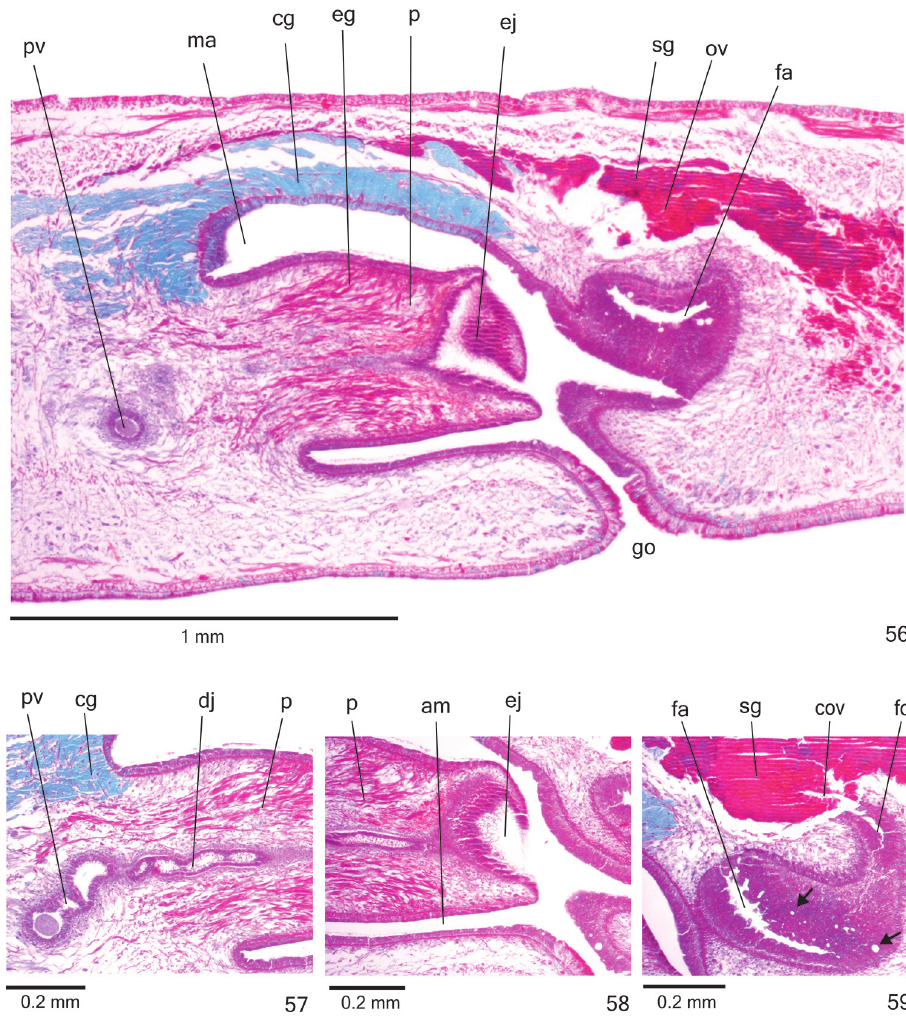
Figures 56–59. Cratera aureomaculata sp. n., holotype, sagittal sections, 56 copulatory apparatus 57 prostatic vesicle 58 penis papilla 59 female organs. Arrows indicate